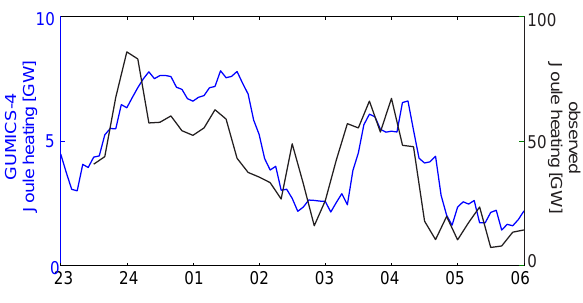
Fig. 9. (left axis, on blue) Total integrated Northern Hemispheric Joule heating in the GUMICS-4 simulation. (right axis, on black) Total integration of Joule heating computed from SuperDARN elec- tric fields and Polar measurements of Pedersen